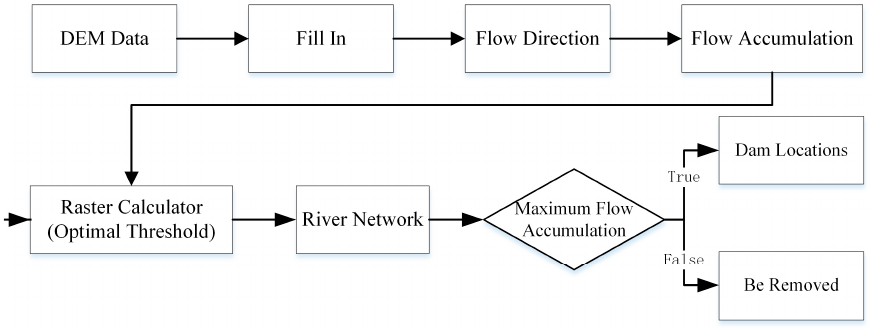
8 of 17 Figure 6. Multi-resolution segmentation results with different scale parameters. ( a ) scale = 60; ( b ) scale = 80; ( c ) scale = 100 (their shape and compactness parameters are all 0.1 and 0.5, respectively). 2.3.4. Feature Fusion The OBIA and deep-learning methods have their advantages. The deep-learning method assigned a probability value of the dam-controlled area for each pixel, while the OBIA provided patches with internal homogeneity. Here, we used majority voting to combine the results of deep learning and OBIA and then determined the dam-controlled areas. First, the patches provided by the OBIA method were overlaid with the probability image. The majority value of the probability image in each patch was calculated and assigned as the patch’s value. Second, referring to the previous experimental results [14], a 0.5 threshold was used to determine the dam patches. If the patches’ value is greater than 0.5, they are regarded as potential dam-controlled areas. Moreover, given that check dams were generally located in gully areas, we used the gully areas to filter noise. The gully areas were extracted from the 5 m DEMs by the multi-directional hillshading method [31–33]. Then, the potential dam patches were overlaid with gully areas. Only the patches located in the gully areas were regarded as true dam-controlled areas.